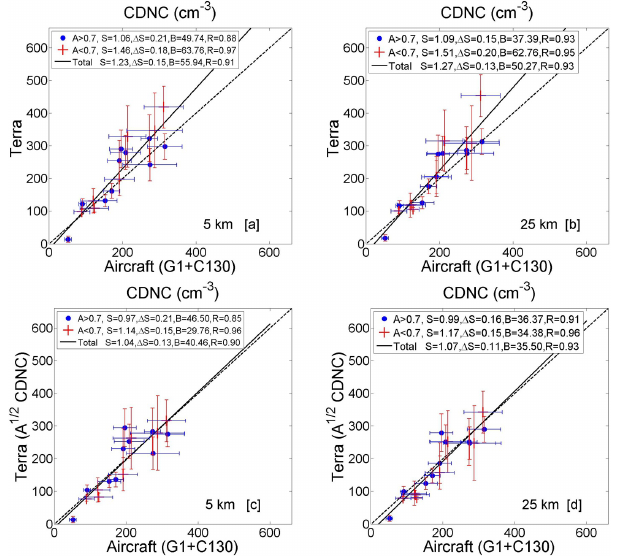
Fig. 8. Comparison of retrieved and modified cloud drop num- ber concentration (CDNC) from MODIS with the in-situ measure- ments: top two plots for the retrieved CDNC, and the bottom two plots for the modified MODIS CDNC. The dashed-lines are for the 1:1 lines; and the solid lines are for the best fit.